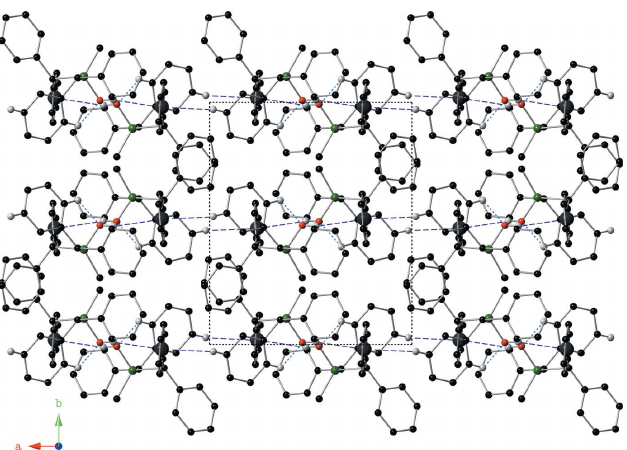
Figure 7 The crystal packing of compound II , viewed along the c -axis, showing the supramolecular ribbons formed by O—H (cid:2)(cid:2)(cid:2) (cid:2) and C—H (cid:2)(cid:2)(cid:2) (cid:2) interactions (Table 2). For clarity, only hydrogen atoms H1, H24 and H27 have been